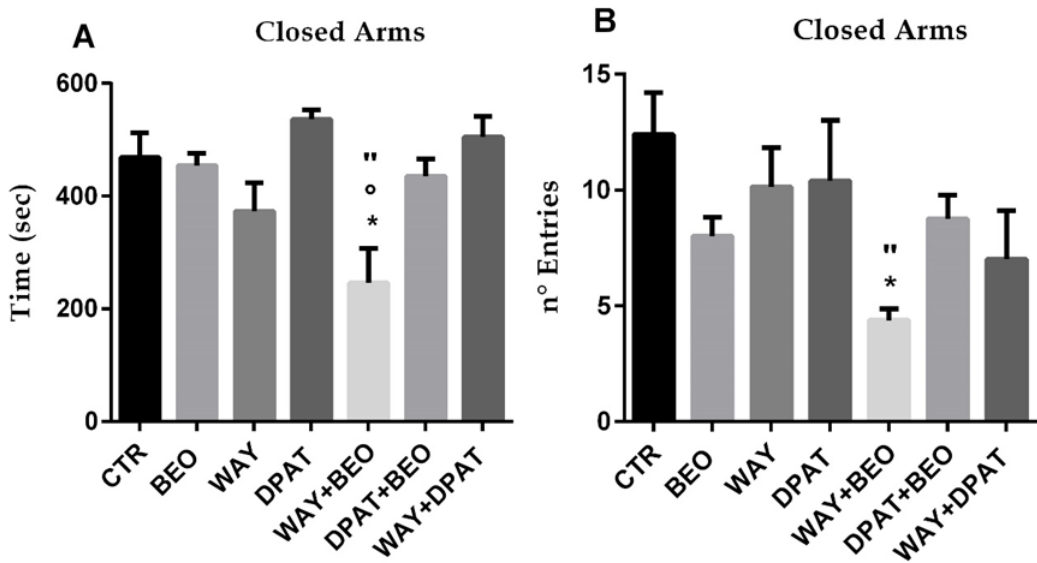
Figure 5. Time spent ( A ) and Number of Entries ( B ) in closed Arms in the elevated plus-maze test in male Wistar rats after systemic (i.p.) administration of jojoba oil (CTR) (500 µ L / kg), Bergamot Essential Oil (BEO) (500 µ L / kg), WAY100635 (WAY) (1 mg / kg), 8-OH-DPAT (DPAT) (1 mg / kg), WAY + BEO (1 mg / kg + 500 µ L / kg), DPAT + BEO (1 mg / kg + 500 µ L / kg), and WAY + DPAT (1 mg / kg + 1 mg / kg). Data are expressed as mean ± SEM ( n = 5–8 per group). * p < 0.05 vs. control group; ◦ p < 0.05 vs. BEO group; “ p < 0.05 vs. WAY group. Statistical analysis was performed by one-way ANOVA followed by individual comparisons with Tukey Multiple Comparison’s test.